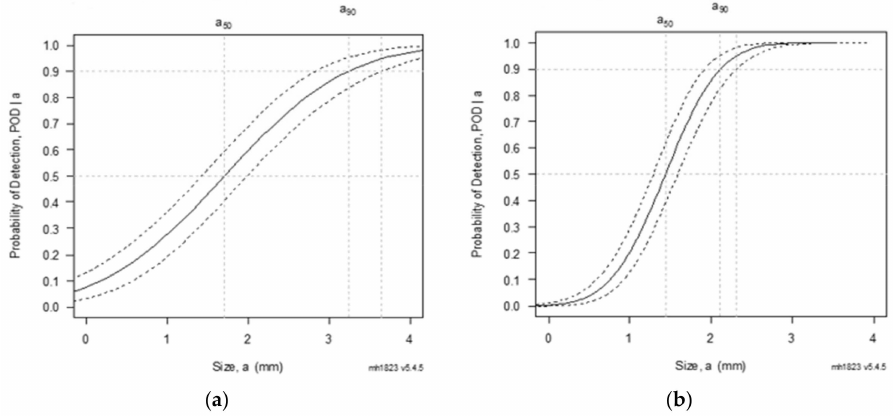
Figure 13. POD curves for detection of steel inserts ( a ) and air voids ( b ) by pulsed thermography. From [3], with